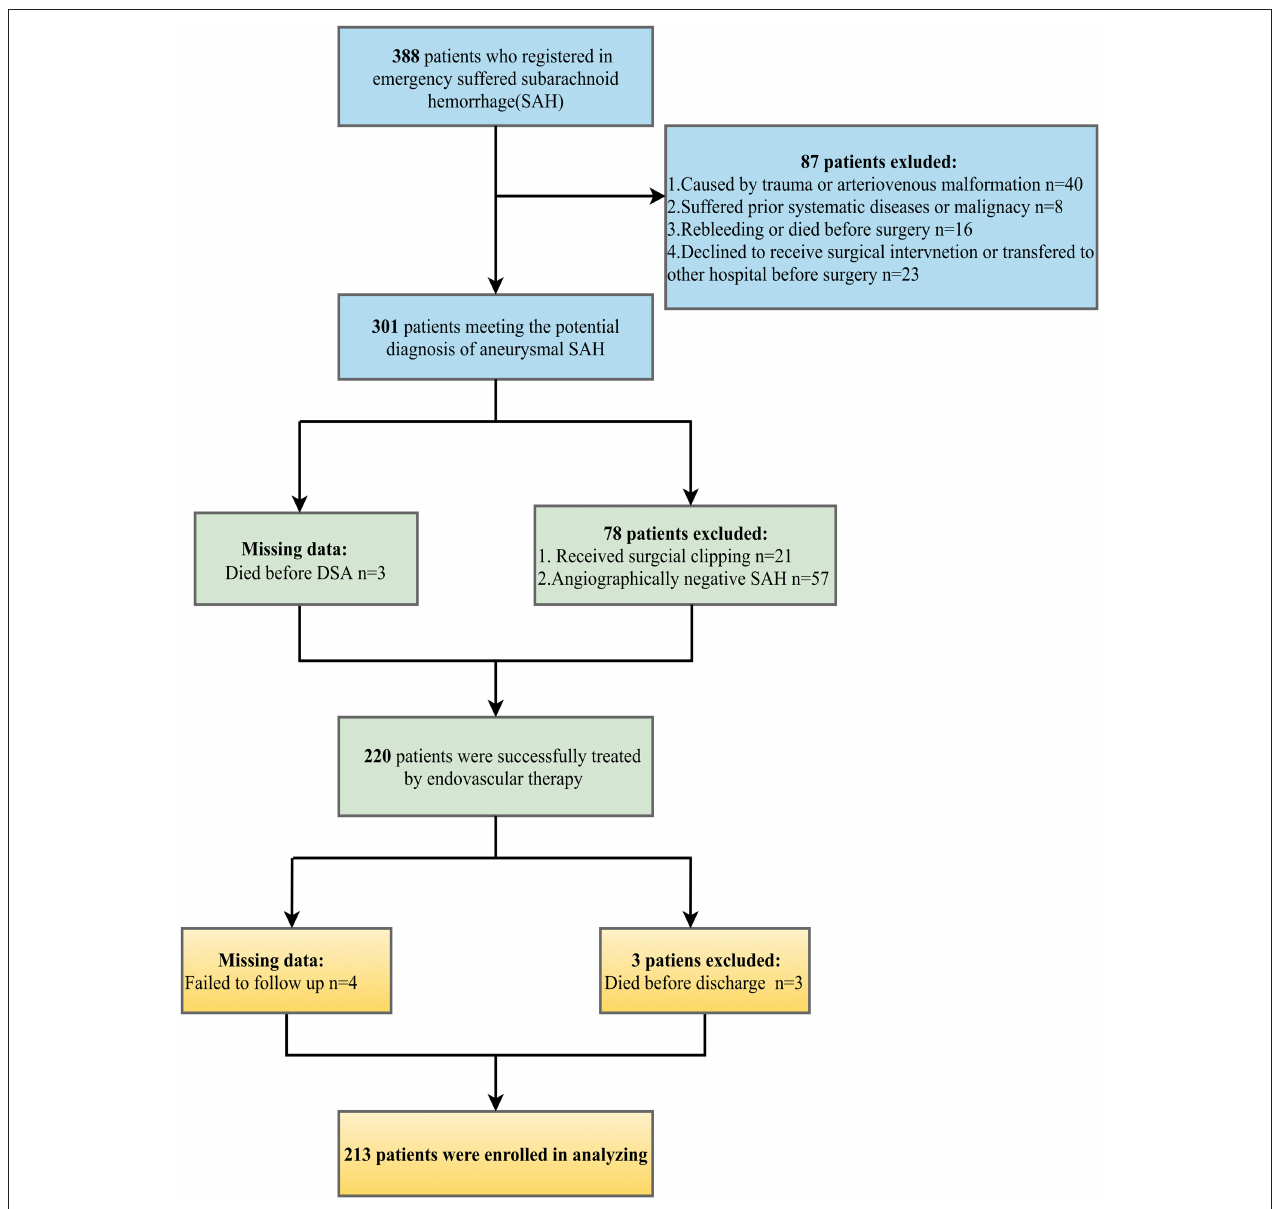
FIGURE 1 | Flow chart outlining inclusion and exclusion